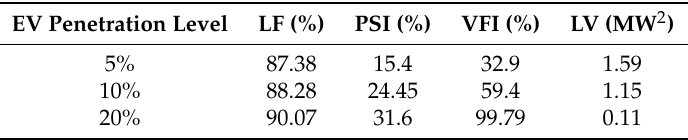
Table 7. Effect of number of EVs on the performance of the scheme.